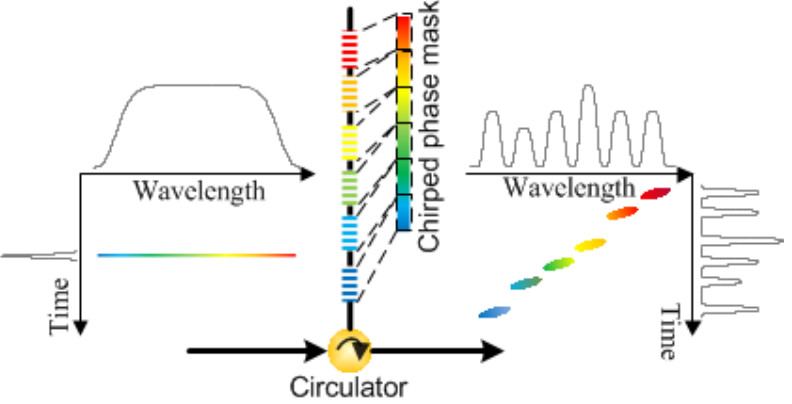
Figure 8. Illustration of the structure and fabrication of a spatially discrete chirped fiber Bragg grating (SD-CFBG) for simultaneous spectral slicing, frequency-to-time mapping and temporal shifting of the input optical pulse, leading to the generation of an optical pulse